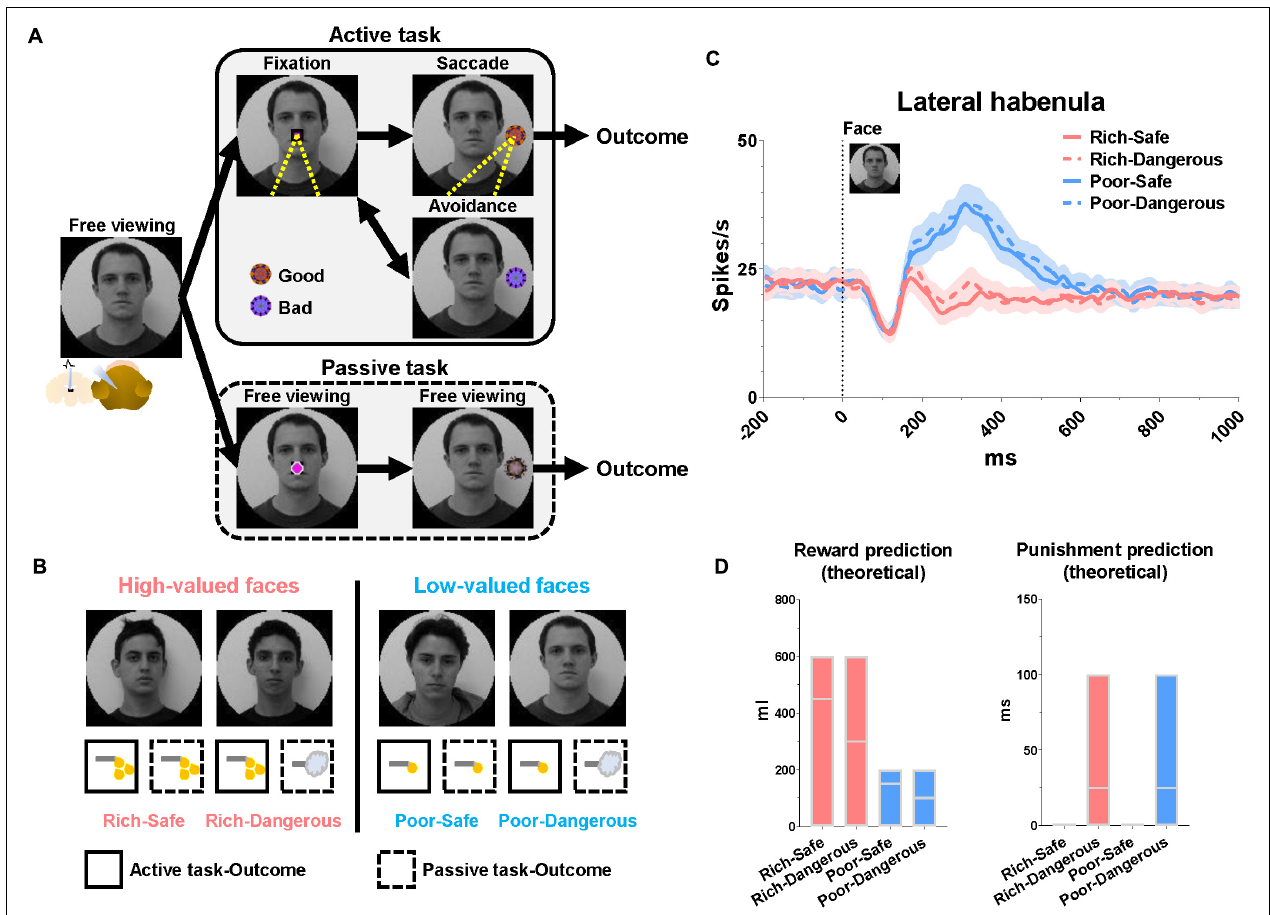
FIGURE 1 | Lateral habenula responses to high- and low-valued faces. (A) Face-based procedure with two distinct behavioral tasks (active and passive). (B) Examples of face images signaling different conditions. Rich and Poor faces were associated with high-valued and low-valued rewards, respectively. Dangerous faces (but not Safe faces) were associated with punishment in the passive mode. (C) Population LHb responses to the faces during the free viewing period before the start of each task. Data were from both monkeys and all recorded LHb neurons averaged across entire sessions. (D) Theoretical reward and punishment predictions at face onset. Floating bars indicate the minimum to the maximum value of outcomes in each trial at the face onset. The lines in the bars indicate the mean value of the reward (Rich-Safe, 450 µ l; Rich-Dangerous, 300 µ l; Poor-Safe, 150 µ l; Poor-Dangerous, 100 µ l) and punishment (Rich-Safe, 0 ms; Rich-Dangerous, 25 ms; Poor-Safe, 0 ms; Poor-Dangerous, 25 ms) in each trial at the face onset. The mean values were determined by the average of all combinations of outcomes in the active and passive conditions ( Supplementary Tables 1,2